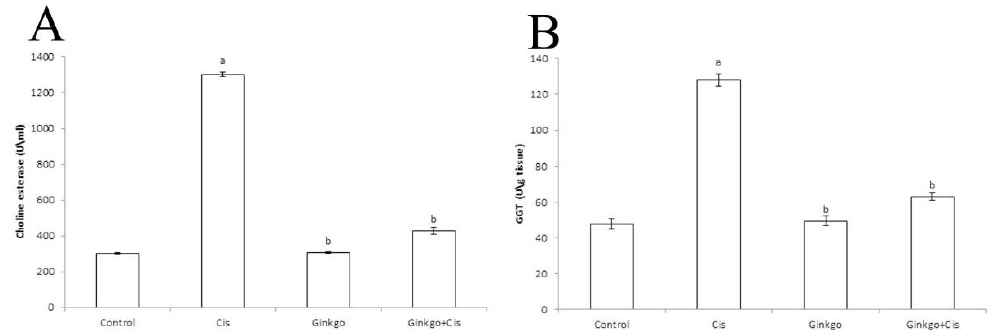
Figure 2. Changes of Cholinestrase (CHE) and Gamma glutamyl transferase (GGT) activities of different groups . The effect of Cis, Ginkgo , and their combination on choline esterase ( A ) and GGT ( B ). Data are presented as mean ± SE ( n = 10). a indicates a significant difference compared to control group, b indicates a significant change compared to Cis group. a and b indicate statistical significance at p < 0.05 using ANOVA followed by Tukey–Kramer as a post ANOVA test.